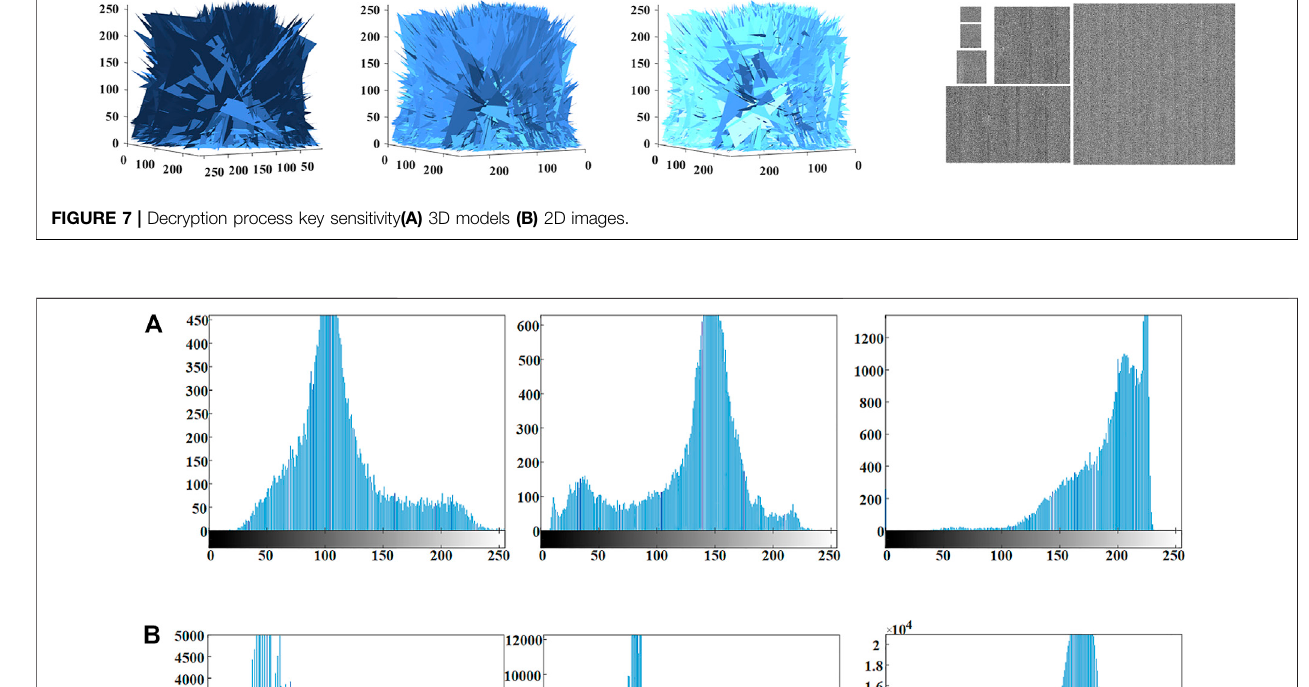
Frontiers in Physics |